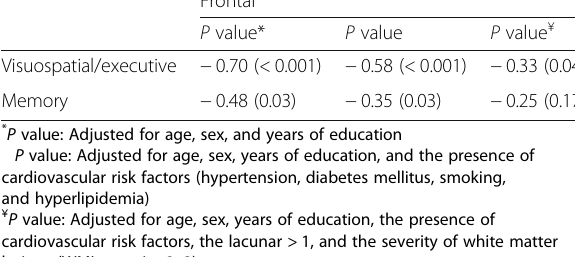
Table 6 Correlations between frontal CMBs and cognitive indices after controlling different parameters Frontal